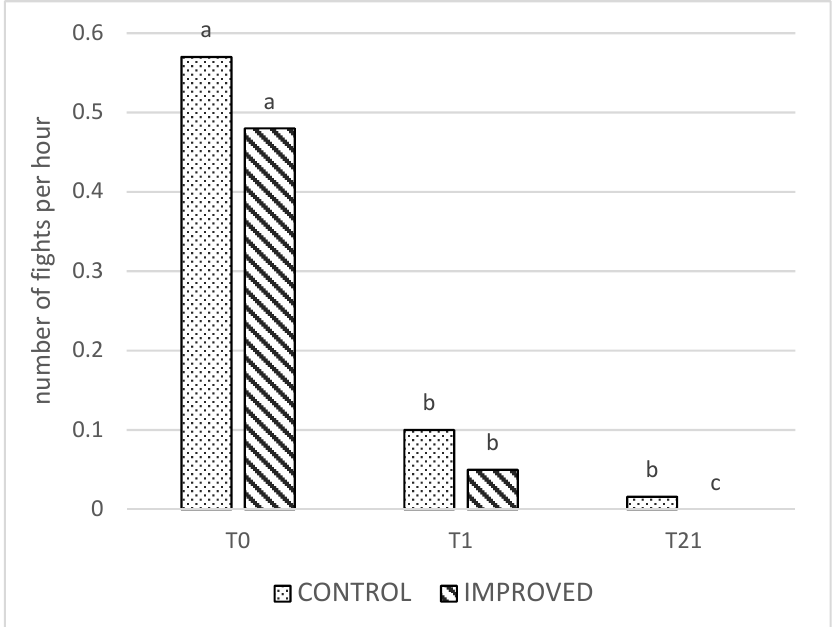
Figure 1. Number of fights per hour in the CONTROL and IMPROVED pens on the day of mixing (T0), the day after mixing (T1), and three weeks later (T21). a, b, c: Different letters indicate significant differences ( p < 0.05) between the treatment and